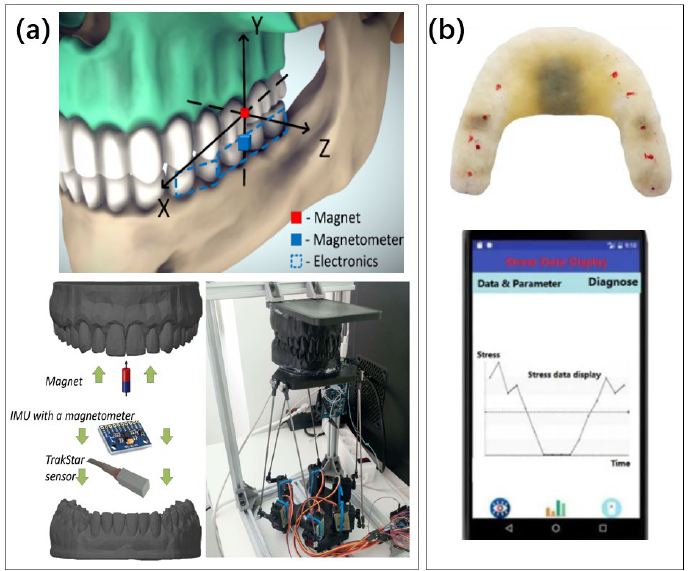
Figure 12. Different methods for detecting bruxism. ( a ) Magnetic field based molar detection [162].